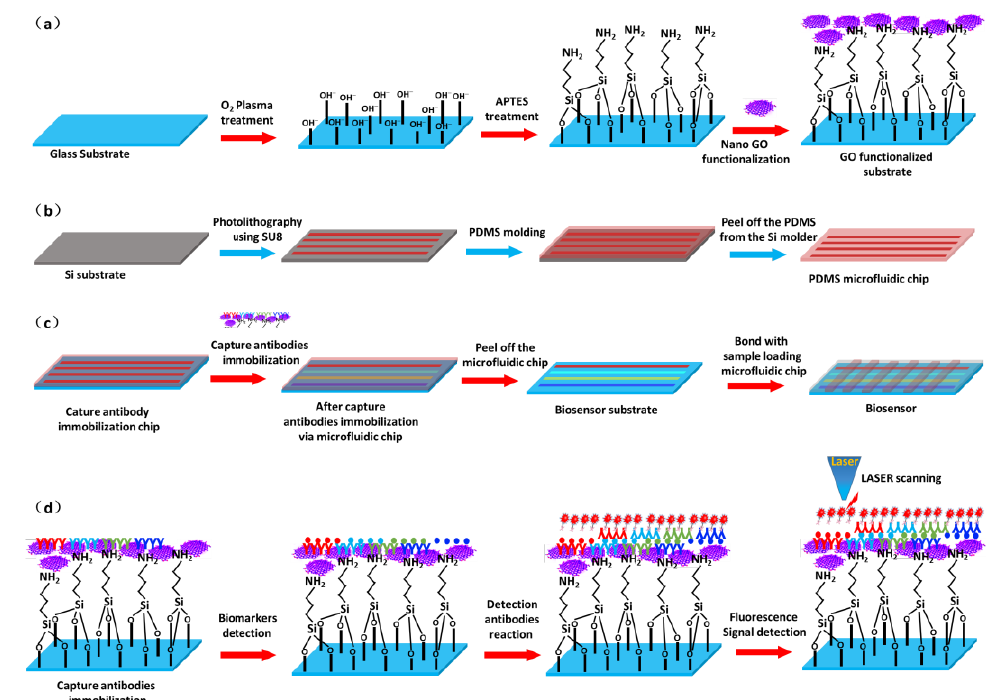
Figure 1. The fabrication schematics of ( a ) the substrate by nanographene oxide functionalization and ( b ) the microfluidic chip. The construction ( c ) and protein biomarker detection ( d ) schematics of the nanographene oxide-functionalized fluorescence microfluidic biosensor.